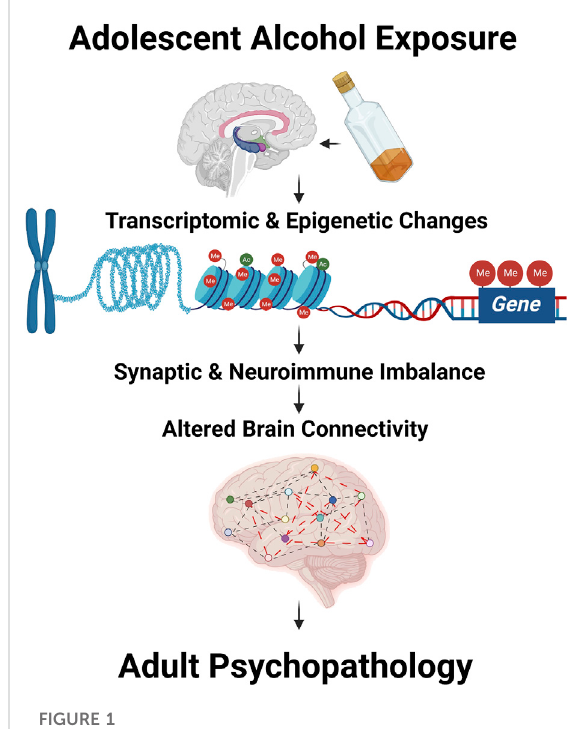
FIGURE 1 Adolescent alcohol exposure modulates transcriptomic and epigenomic changes leading to altered synaptic and neuroimmune imbalance and abnormal brain structural changes including brain connectivity. These changes together may drive the adult psychopathology after adolescent alcohol